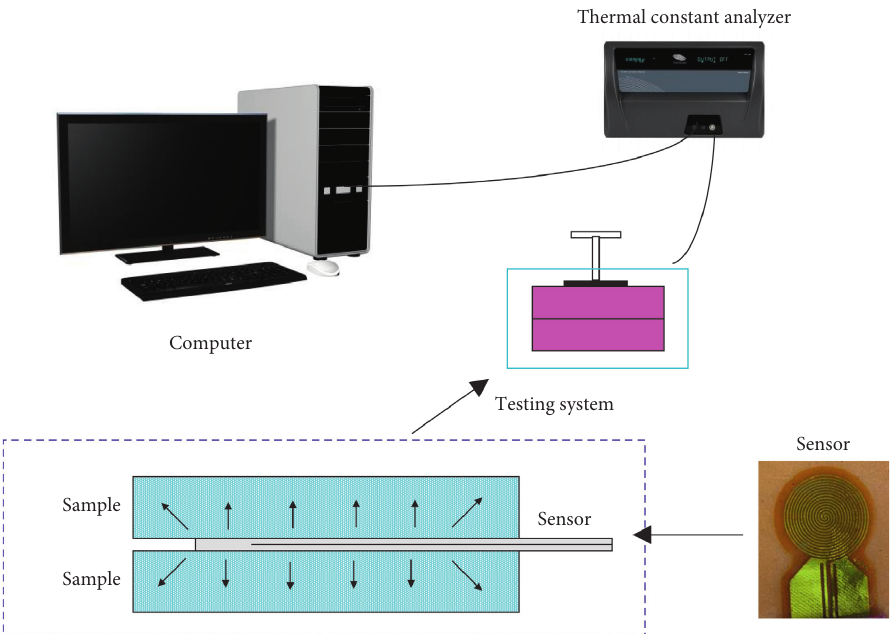
Figure 5: Thermal conductivity measuring device used in this study.